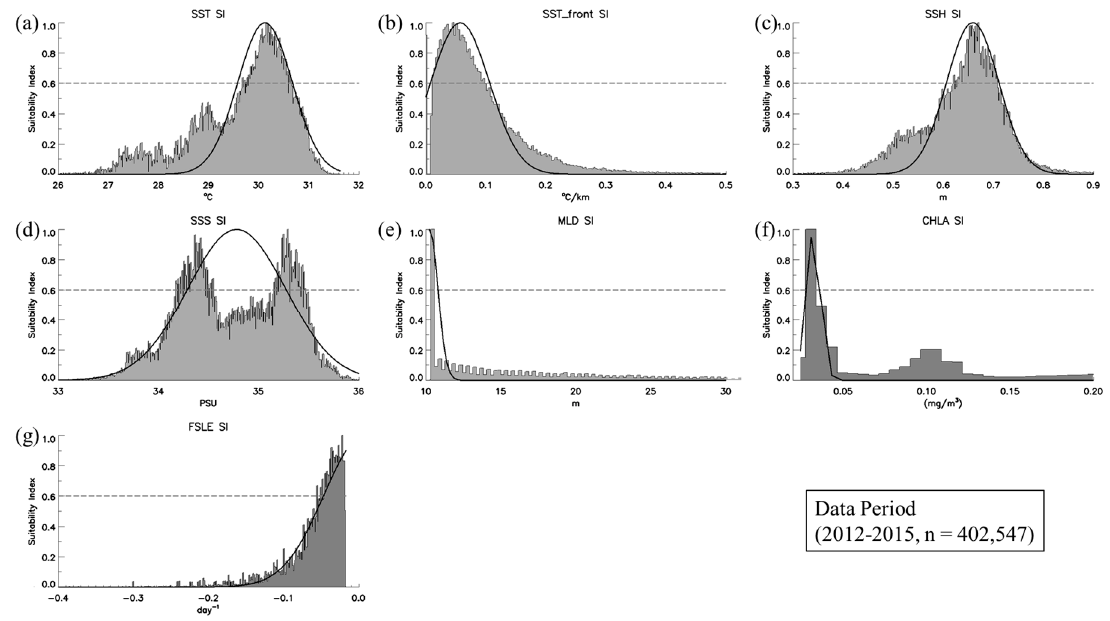
Figure 7. Suitability index curve for environmental variables: ( a ) SST, ( b ) SST front, ( c ) SSH, ( d ) SSS, ( e ) MLD, ( f ) CHLA, and ( g ) FSLE. The gray bars, solid curve lines, and dotted lines show the SI values, fitted SI curves, and 0.6 intervals (good habitat), respectively.